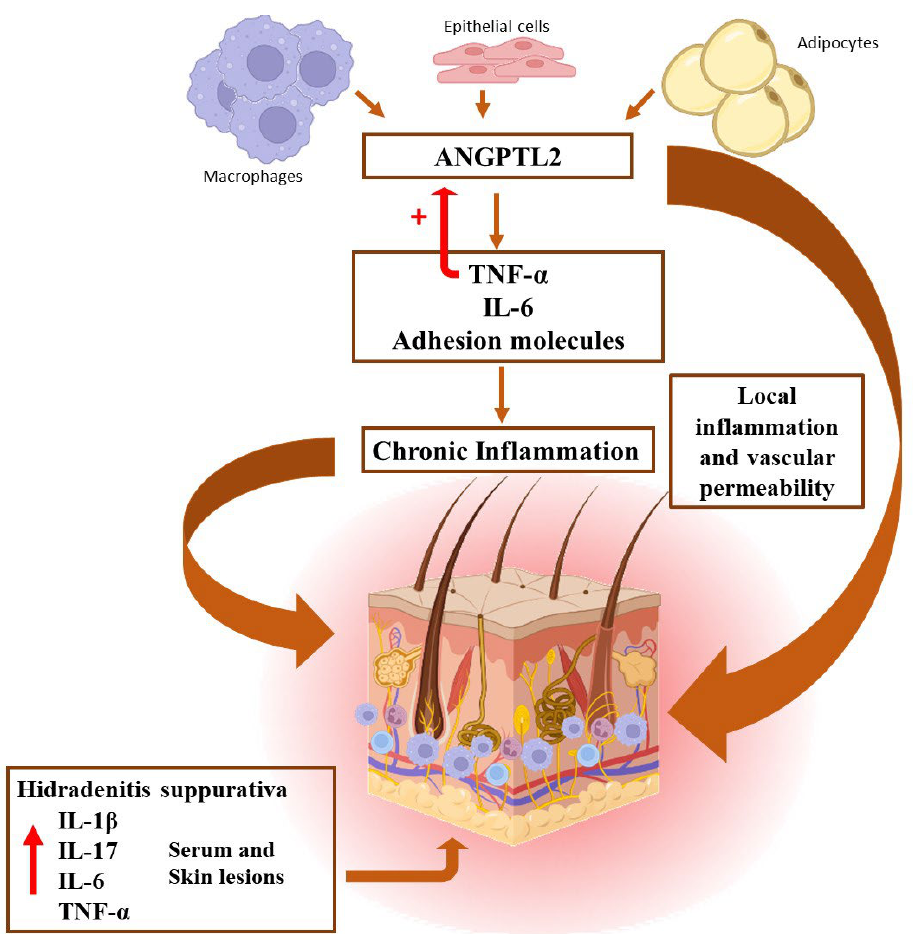
Figure 3. Illustrative scheme showing the pathophysiological mechanisms involved in the develop- ment of HS lesions.